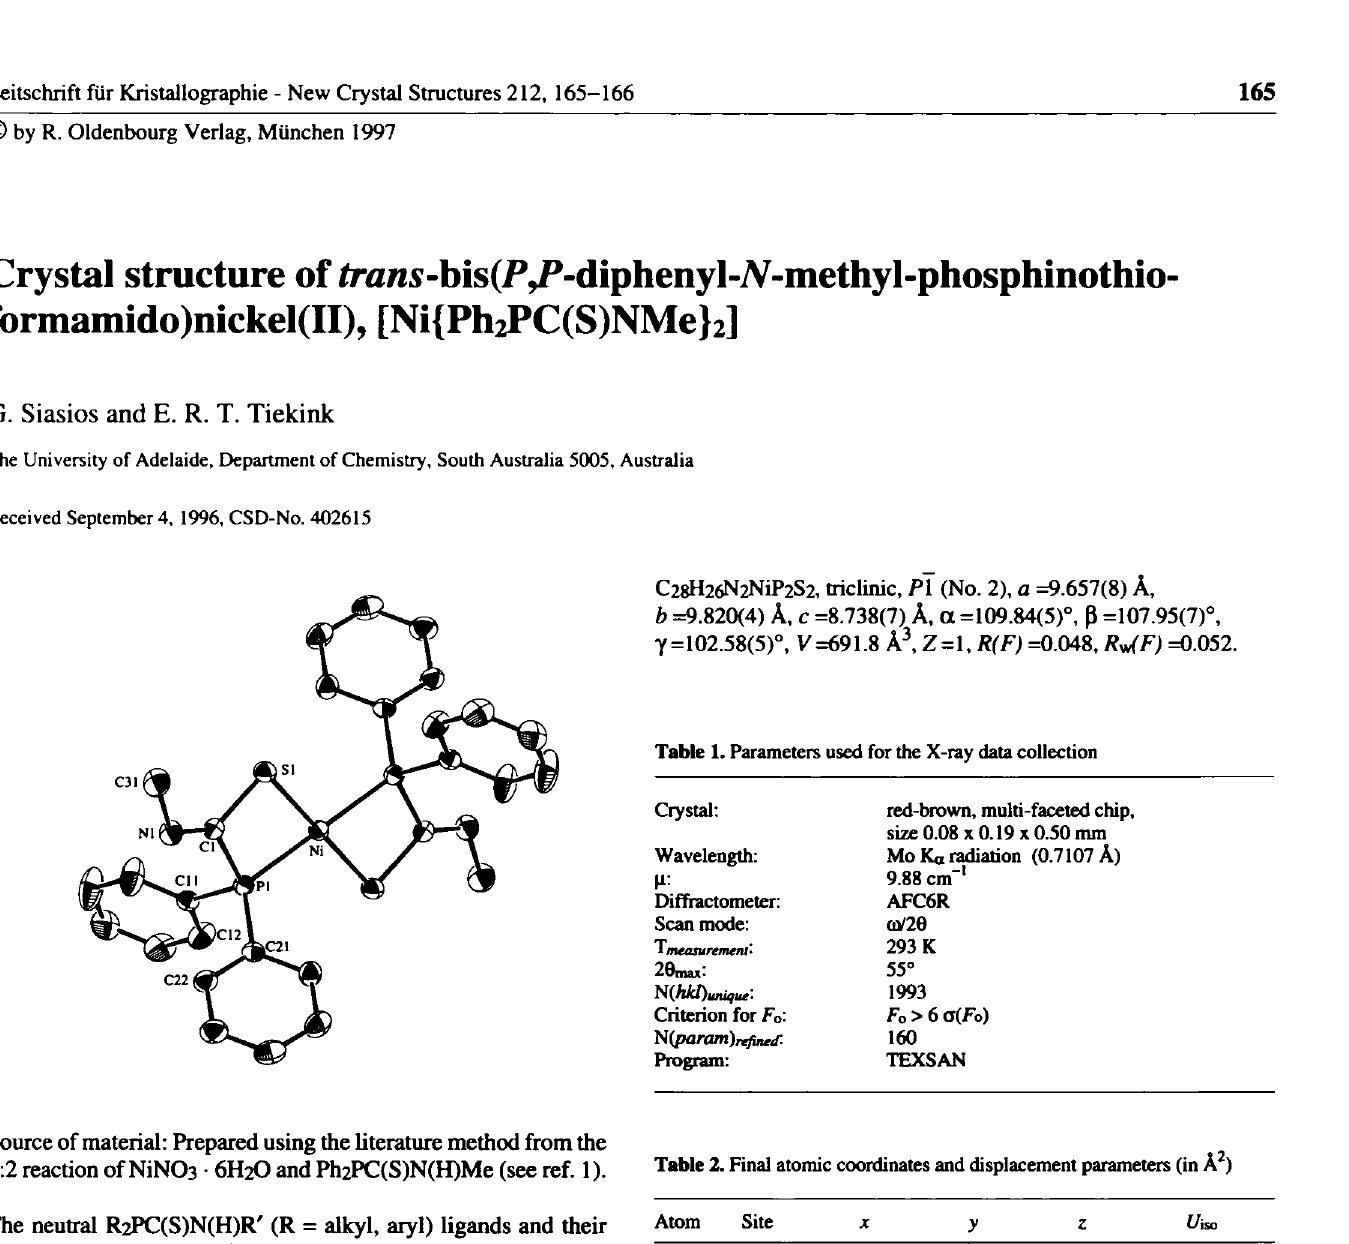
Table 3. Final atomic coordinates and displacement parameters (in Â 2